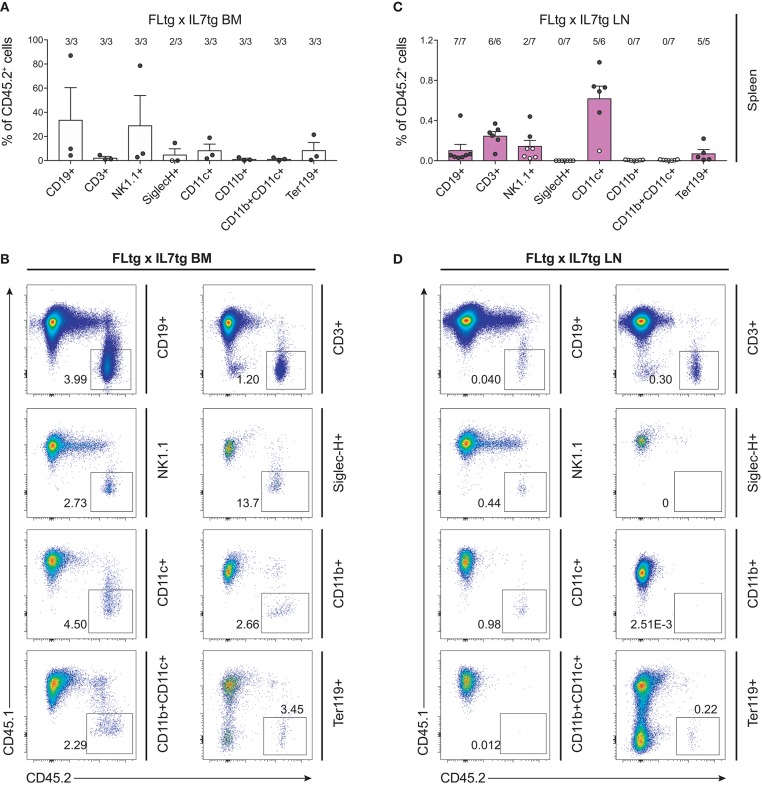
Hematopoietic reconstitution potential of FLtgxIL7tg LN cells after secondary transplantation. (A,C) Percentage of CD45.2+ donor cells within the indicated lineages in spleens of secondary CD45.1+ recipients, which received BM of CD45.1+ mice reconstituted with FLtgxIL7tg BM (A) or FLtgxIL7tg LN (C). Results from three independently performed experiments are shown. Bars indicate mean ± standard error of the mean. Black circles represent mice where the corresponding lineage was scored as positive for the presence of donor-derived cells (>50 cells in the CD45.2+ gate) and white circles mice with no reconstitution (<50 cells in the CD45.2+ gate). The ratio of positive-to-total mice analyzed for each lineage is indicated above the corresponding bar. Lineages were defined as follows: CD19+: CD11b−CD11c−CD3−CD19+; CD3+: CD11b−CD11c−CD19−CD3+; NK1.1+: CD3−CD11c−B220−SiglecH−NK1.1+; SiglecH+: CD11b−NK1.1−B220+SiglecH+; CD11c+: NK1.1−SiglecH−B220−CD11b−CD11c+; CD11b+: NK1.1−SiglecH−B220−CD11c−CD11b+; CD11b+CD11c+: NK1.1−SiglecH−B220−CD11b+CD11c+; Ter119+: Ter119+. (B,D) Representative FACS plots showing the CD45.2+ donor population identified within the lineages shown in (A,C). Left: FLtgxIL7tg BM as primary donor; right : FLtgxIL7tg LN as primary donor.